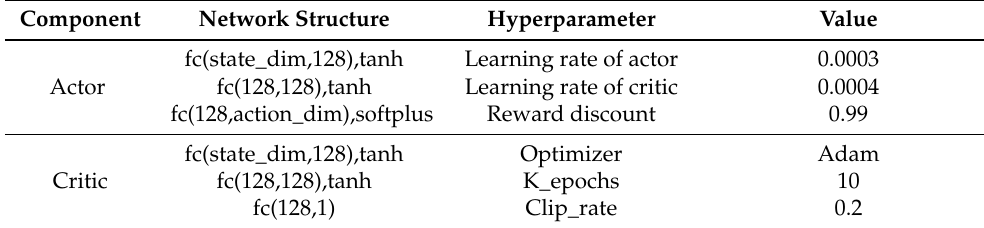
Table 3. Hyperparameters of